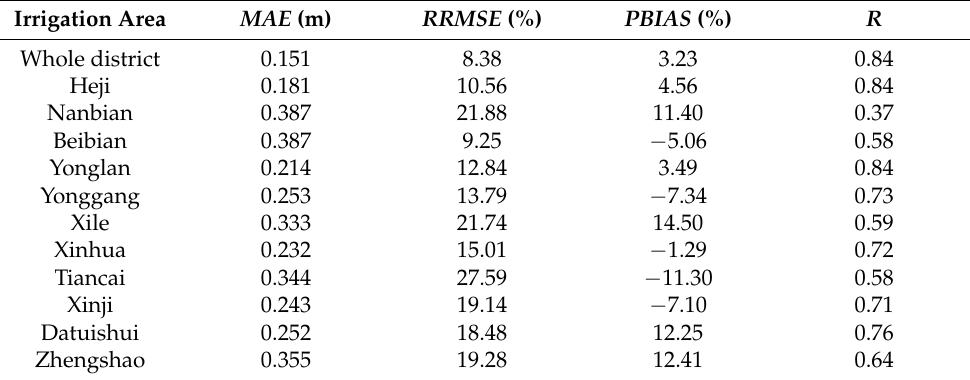
Figure 7. Comparison results of calculated and observed water table depth during the calibration and validation periods in ( a ) the whole district, ( b ) Heji sub-irrigation district, ( c ) Xile sub-irrigation district, ( d ) Datuishui sub-irrigation district and ( e ) the well-irrigated area. Table 2. Model evaluation indexes of calculated and observed water table depth during the freez- ing-thawing period.